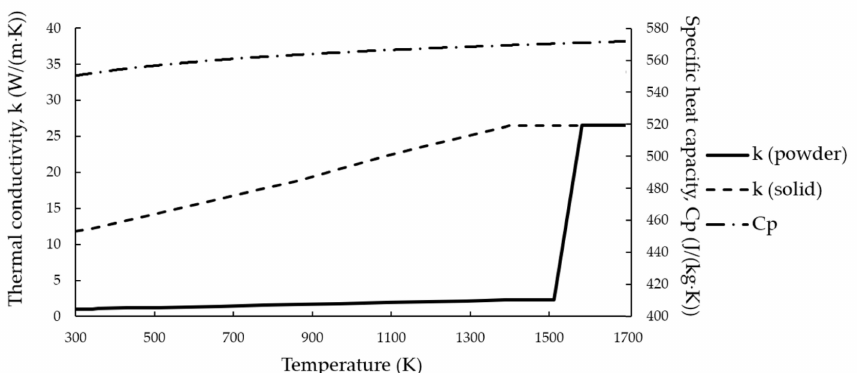
Figure 2. Temperature dependences on thermal conductivity and specific heat